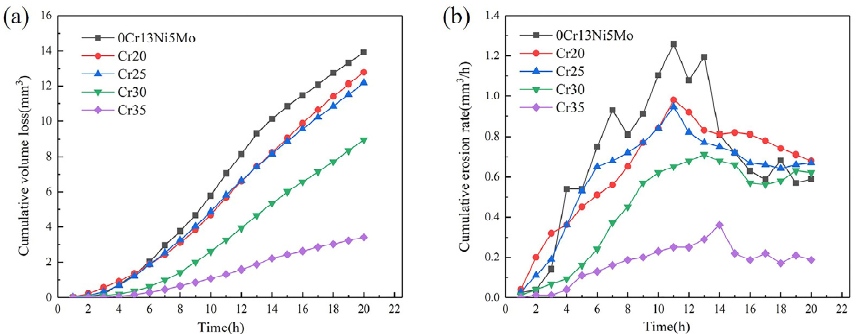
Figure 9. CVL curves ( a ) and CVR curves ( b ) as a function of cavitation duration of CoCr x FeMnNi HEA coatings and 06Cr13Ni5Mo steel. HEA coatings and 06Cr13Ni5Mo